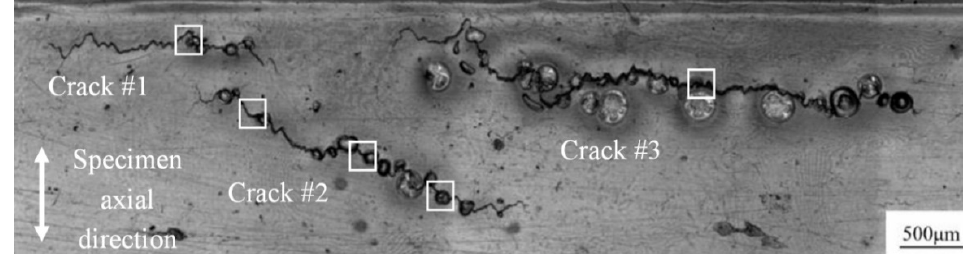
Figure 5. Crack locations and crack sources of specimen ORB2.